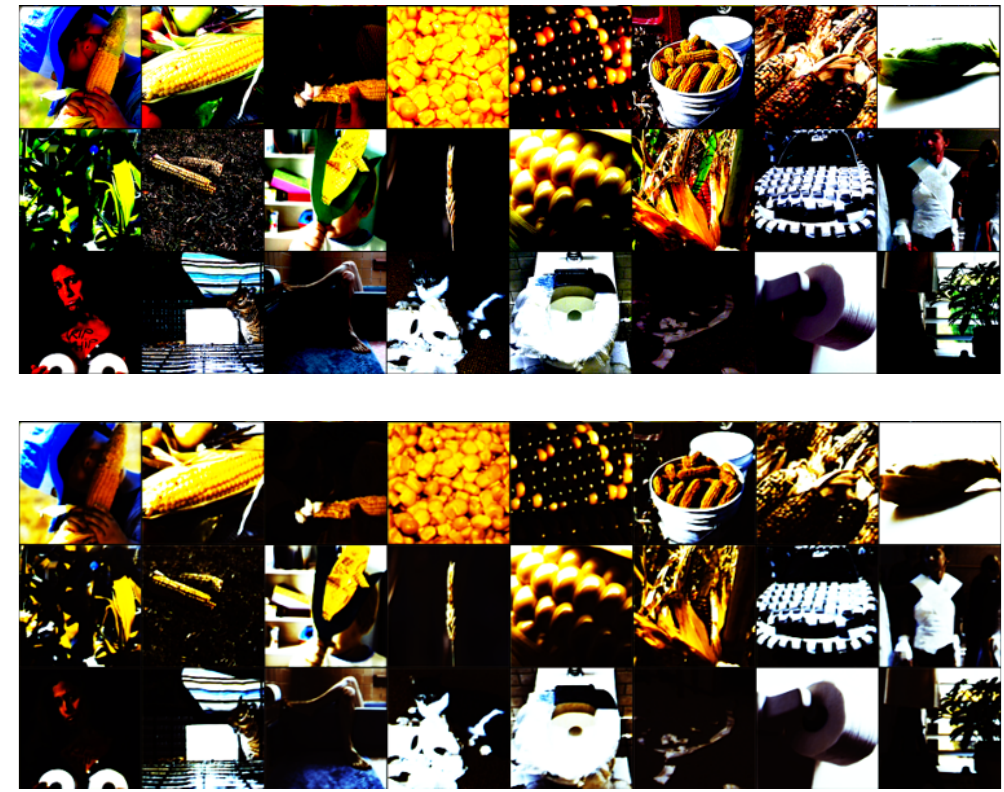
Figure 3. Examples of reconstructed images in the ImageNet dataset. The original images (256 × 256) were randomly clipped to 224 × 224. The top group contains original clipped images, and the bottom group contains the outputs of CAE trained by